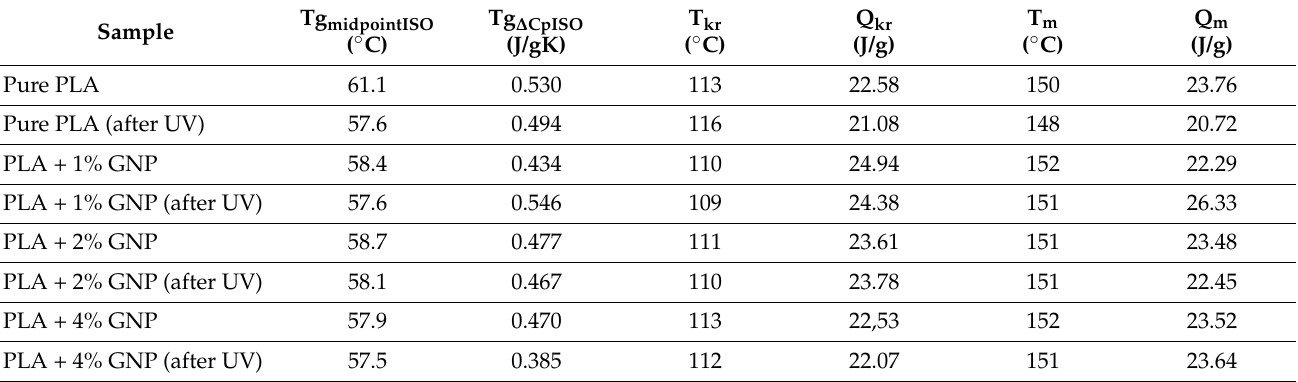
Table 4. The data obtained by the DSC for PLA samples and PLA/graphene